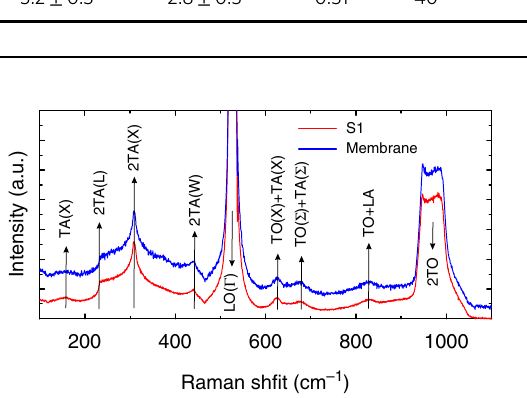
Fig. 4 One- and two-phonon Raman spectra. Data obtained for pristine 250 nm membrane and S1 at room temperature in x 3 x 1 x 1 ð Þ x 3 scattering geometry. The arrows indicate critical points of the fi rst Brillouin zone of bulk silicon, where TA and TO are transverse acoustic and optical modes, respectively, and LO are longitudinal optical modes